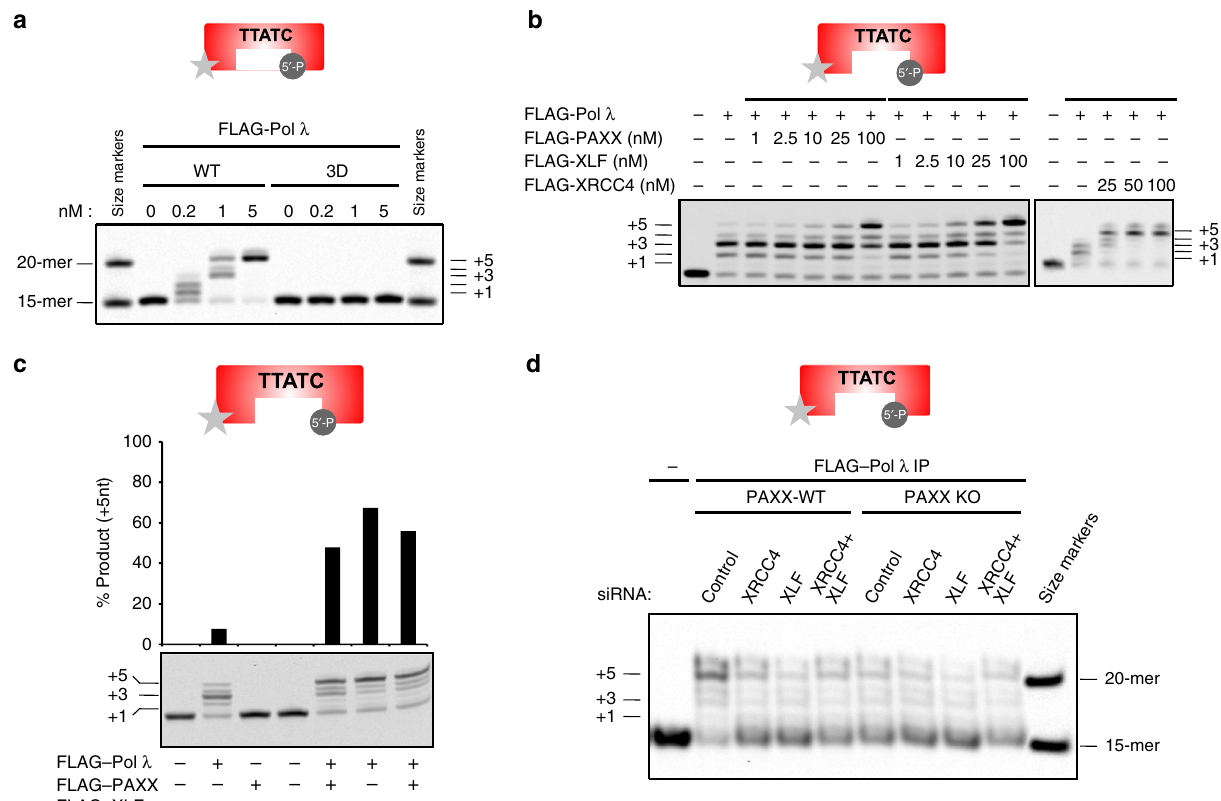
Fig. 6 XRCC4 family proteins stimulate gap fi lling synthesis activity of Pol λ . a Gap fi lling activity of Pol λ -WT and a catalytically inactive Pol λ -D427A/ D429A/D490A mutant. b PAXX, XLF and XRCC4 stimulate gap- fi lling synthesis activity of Pol λ with an IRDye ® 700-labelled 5nt-gapped dsDNA (33- mer) substrate. c As described in Panel B, except that some reactions also contained either FLAG-PAXX or – XLF alone d Gap fi lling synthesis assays were performed as described in Panel B with Pol λ immunoprecipitated from RPE-1 PAXX + / + or PAXX KO cells incubated with or without XLF or XRCC4